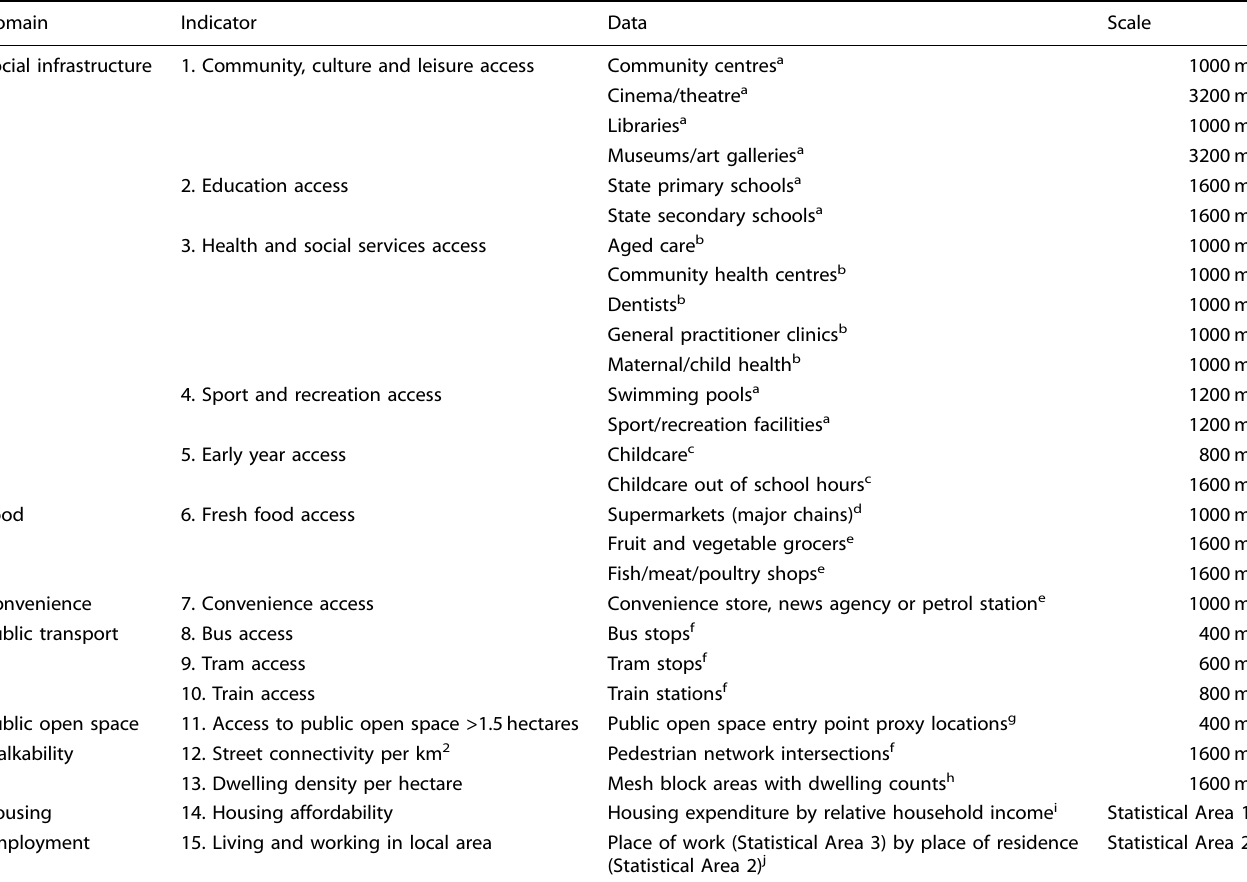
Table 5. Indicators included in the revised urban liveability